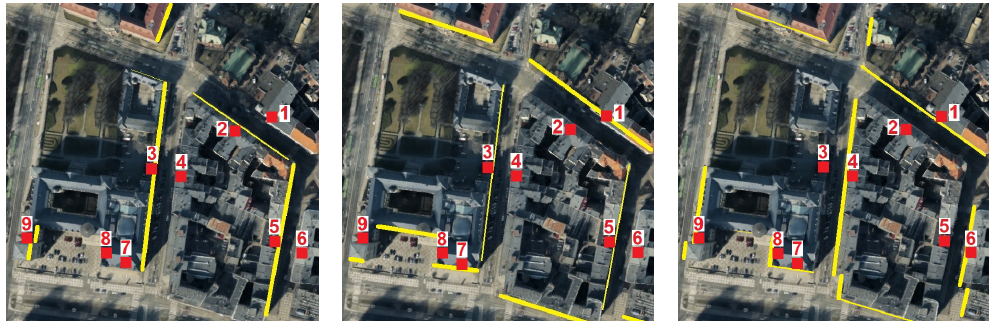
Figure 1. Illustration of the availability of solar energy in dense urban areas for several periods of the day (in the morning, at noon, and in the afternoon). The thickness of the yellow lines illustrates the energy level at a given point, while red squares mark the selected positions of the air pollution sensors (prepared on the basis of Google maps street